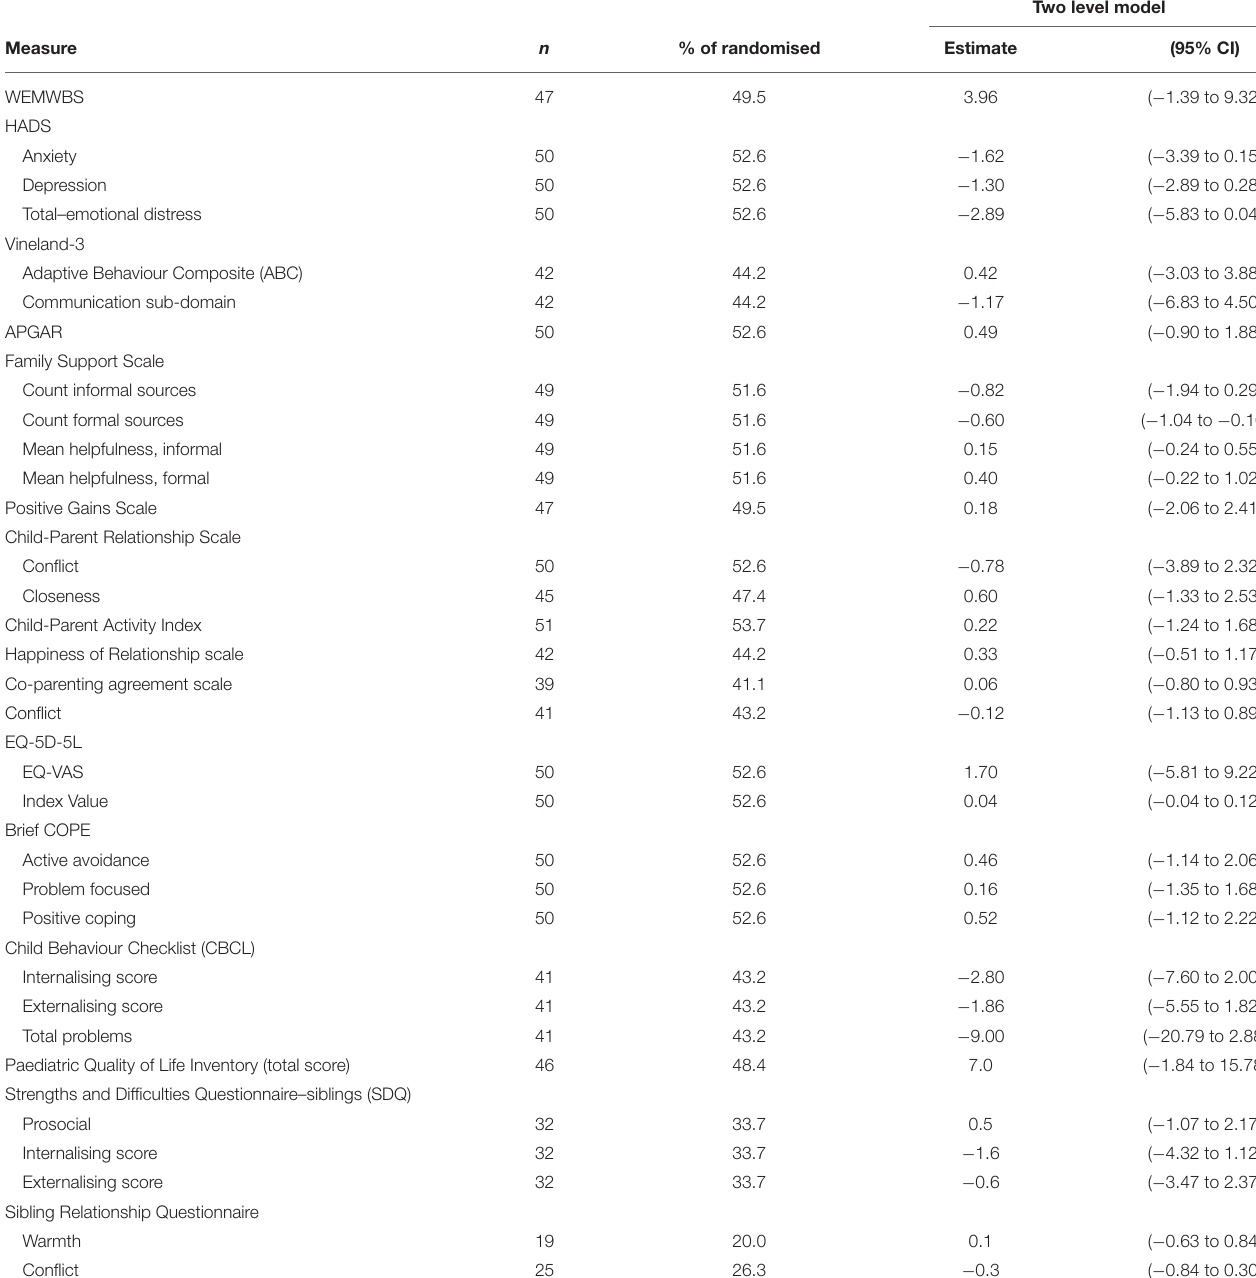
TABLE 7 | Two level regression analysis, comparing intervention to control